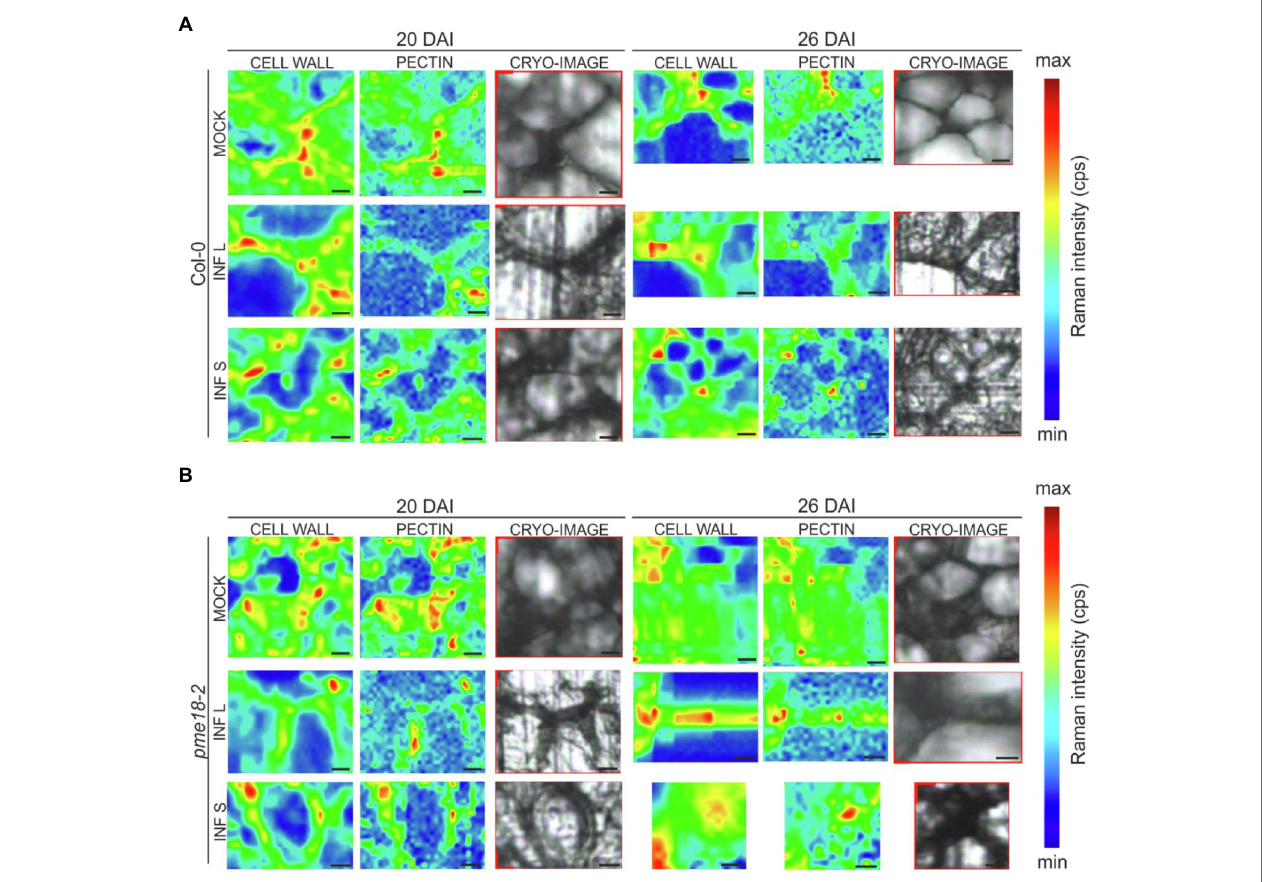
FIGURE 5 | Raman images of cell wall junctions in hypocotyl region of Col-0 plants and the pme18-2 mutant before and after infection with P. brassicae . The Raman maps for cell junction regions of infected (INF) and non-infected (MOCK) cells within hypocotyls were obtained by integrating bands from 2760 to 3100 cm − 1 (C–H stretching vibration, reflecting distribution of cell wall material) and from 840 to 885 cm − 1 (corresponds to the band for the (C–O–C) skeletal mode of α -anomers in pectin). On the right side, cryo-section bright field images of scanned regions are provided. Panel (A) shows representative cell junctions images for Col-0 genotype, whereas panel (B) images for pme18-2 mutant. Separate images were taken for cell junctions of enlarged cells (INF L) and those that did not undergo pathogen-driven expansion (INF S). Scale bars represent 10 μ m. The color scale represents the Raman intensity counts per second of a band visualized in a particular